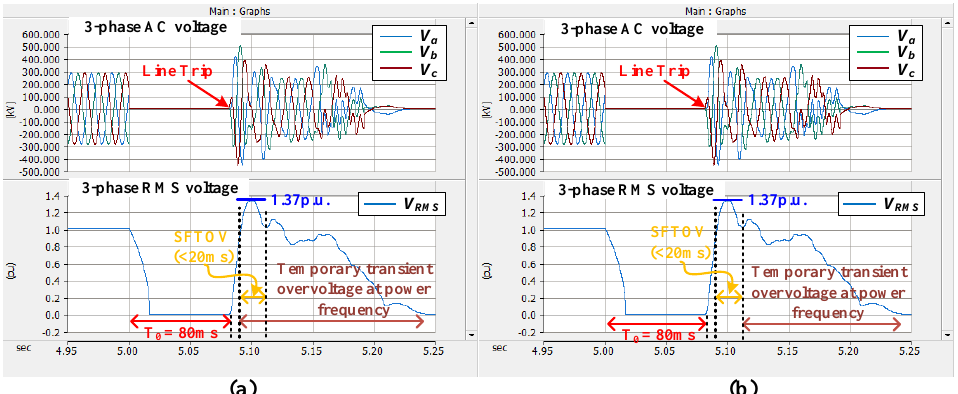
Figure 9. PSCAD/EMTDC simulation results according to EMT simulation time step. ( a ) 100 µ s and ( b ) 10 µ